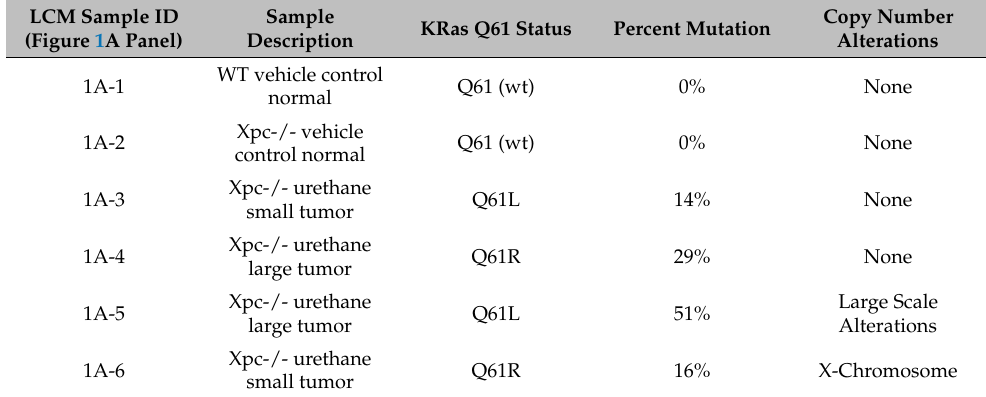
Table 1. Summary of Kras Q61 mutations and copy number variations found in mouse LCM samples modeling lung adenocarcinoma.